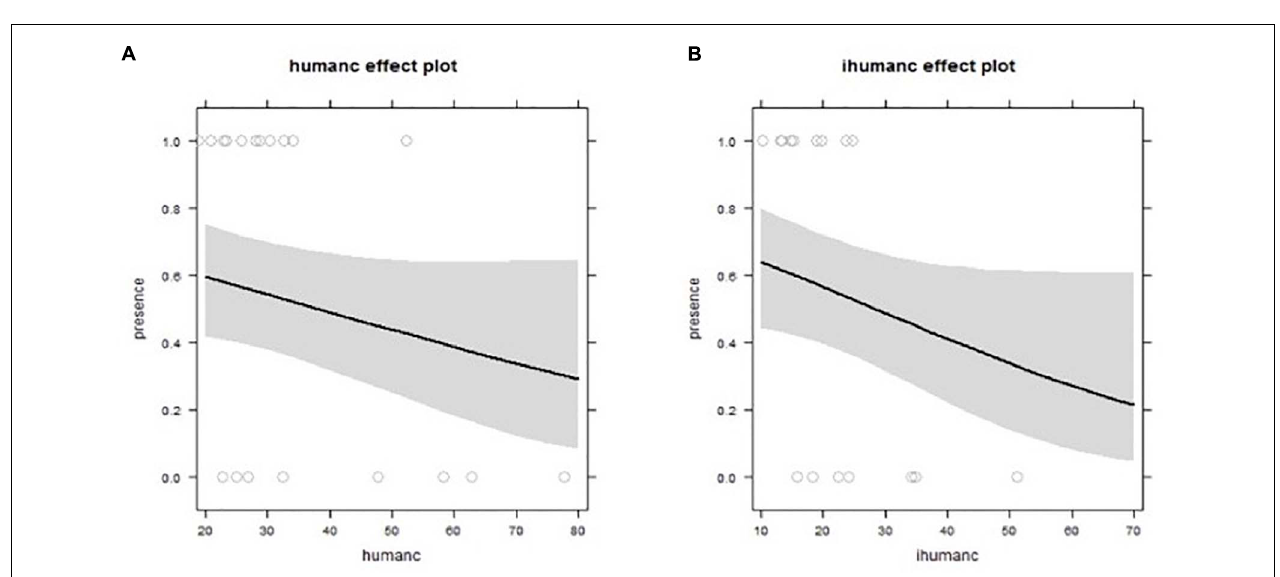
FIGURE 6 | Numbers of occupied territories over in 1995, 2010, and 2014s in five study areas around the south of Lake Naivasha. Overall numbers declined from 38 occupied territories in 1995 to only 20 occupied territories in 2014, a decline of 47%.